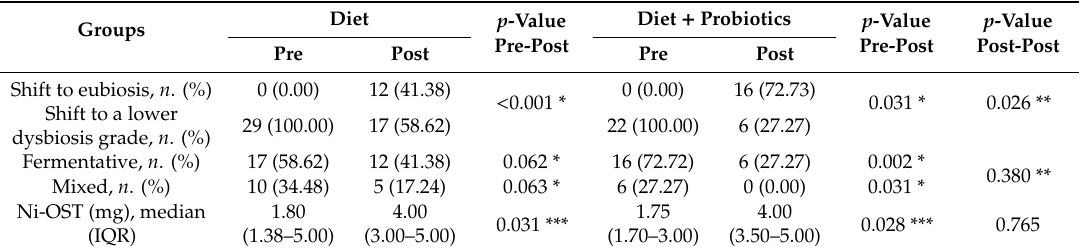
Table 5. Absolute and percent distribution of patients pre- and post-treatment with only diet or diet plus probiotics and comparisons of results obtained between patients who shifted to eubiosis or lower grade